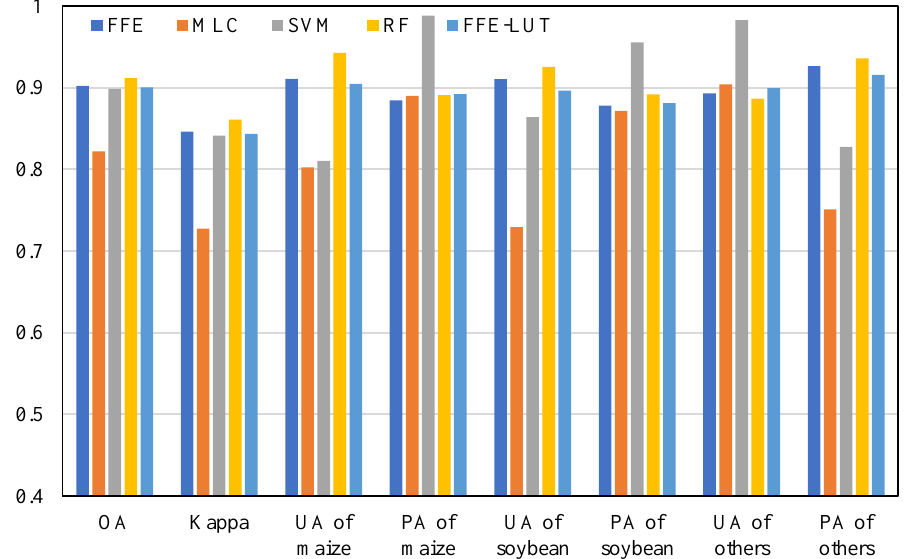
Figure 12. Accuracy assessment of each classification method. OA: overall accuracy; PA: producer’s accuracy; UA: user’s accuracy.